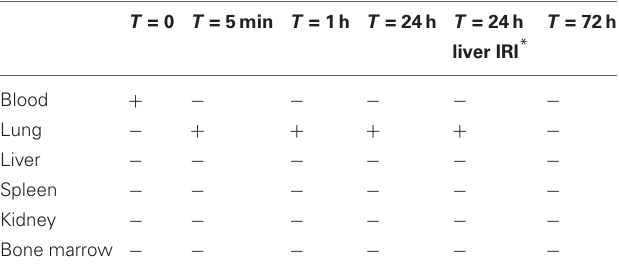
Five animals were included per